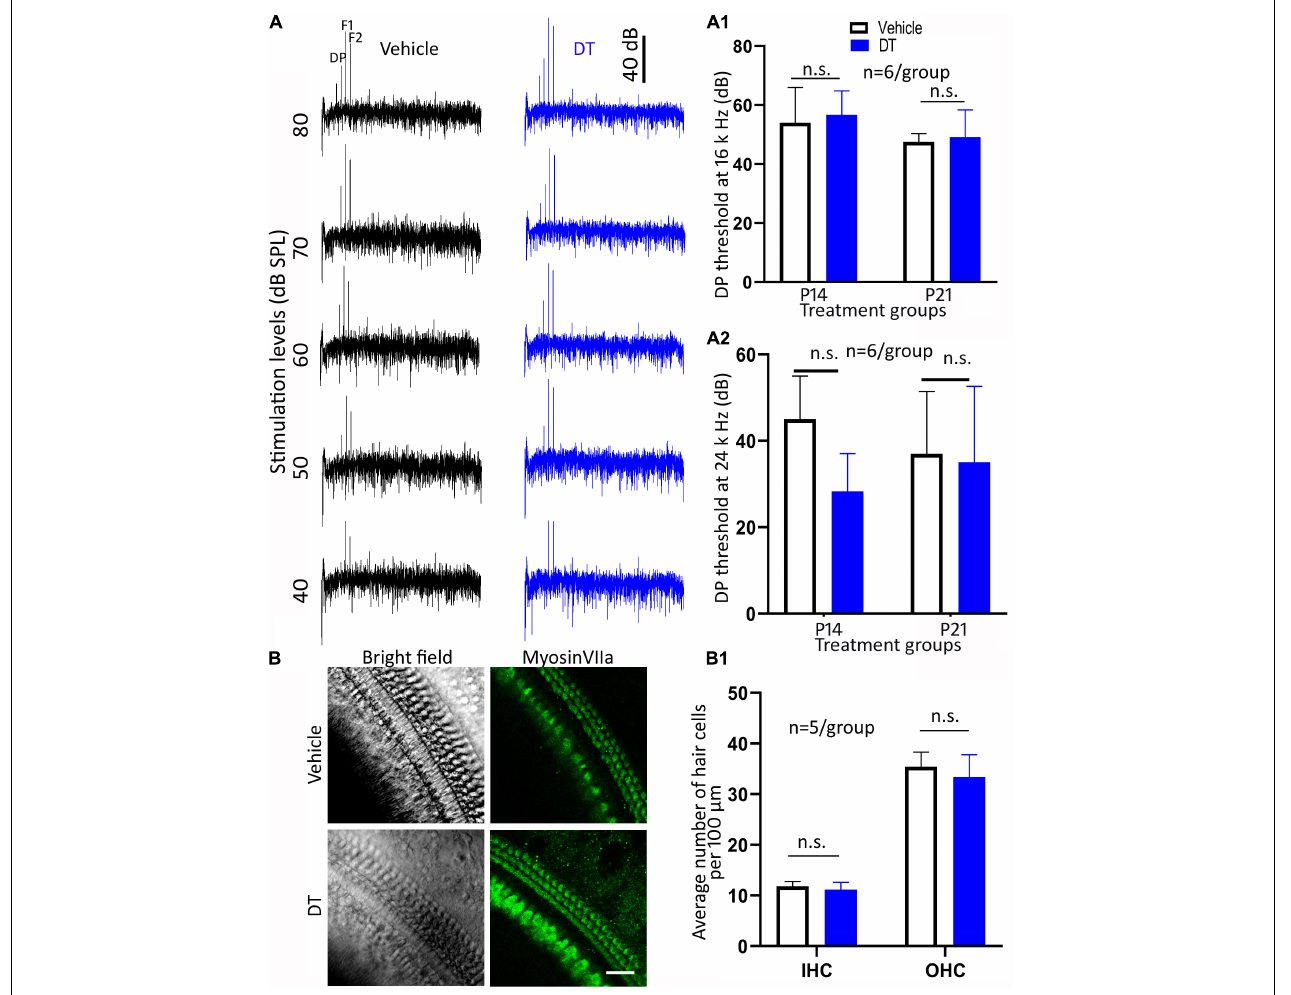
FIGURE 5 | Hair cell protein expression and distortion product otoacoustic emission (DPOAE) study. Representative DPOAE waveforms of Nefl CreER / + ;iDTR + / − mice treated with either diphtheria toxin (DT) or vehicle are shown in (A) . In the quantitative study, DPOAE measurements at 4 weeks old did not show a significant difference between the DT and vehicle treatments at 16 (A1) or 24 kHz (A2) in the P14 or P21 groups (two-way ANOVA: p > 0.05, n = 6 mice/group). In the surface preparation of Nefl CreER / + ;iDTR + / − mice treated with either DT or vehicle on P14, the numbers of myosin VIIa-expressing cells are statistically insignificant ( B,B1 ; ANOVA: p > 0.05, n = 5 mice/group). n.s. statistically insignificant. Scale , 25 µ m in (B)